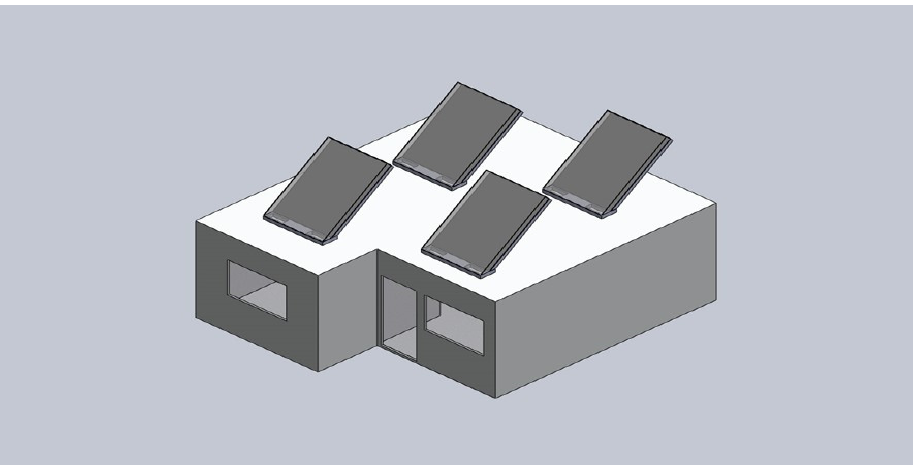
Figure 3. Layout of the solar chimney modules in the house.